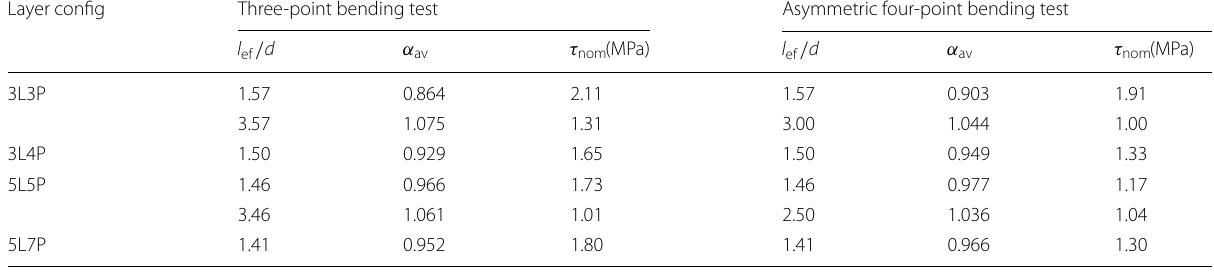
Table 6 Magnitude of shear stress in cross layer ( α av ) Layer config Three-point bending test Asymmetric four-point bending test